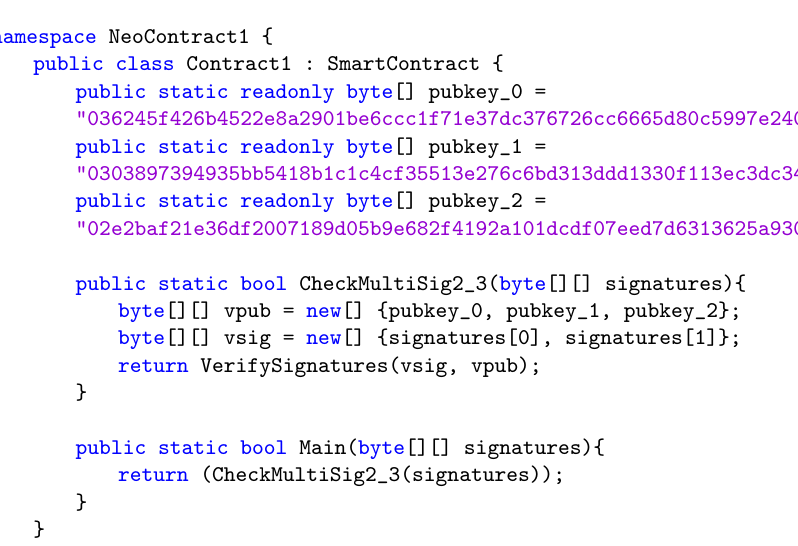
Algorithm 4 Smart Contract code in C# that is equivalent to the smart account generated for the multi signature example. using Neo.SmartContract.Framework; using Neo.SmartContract.Framework.Services.Neo; using